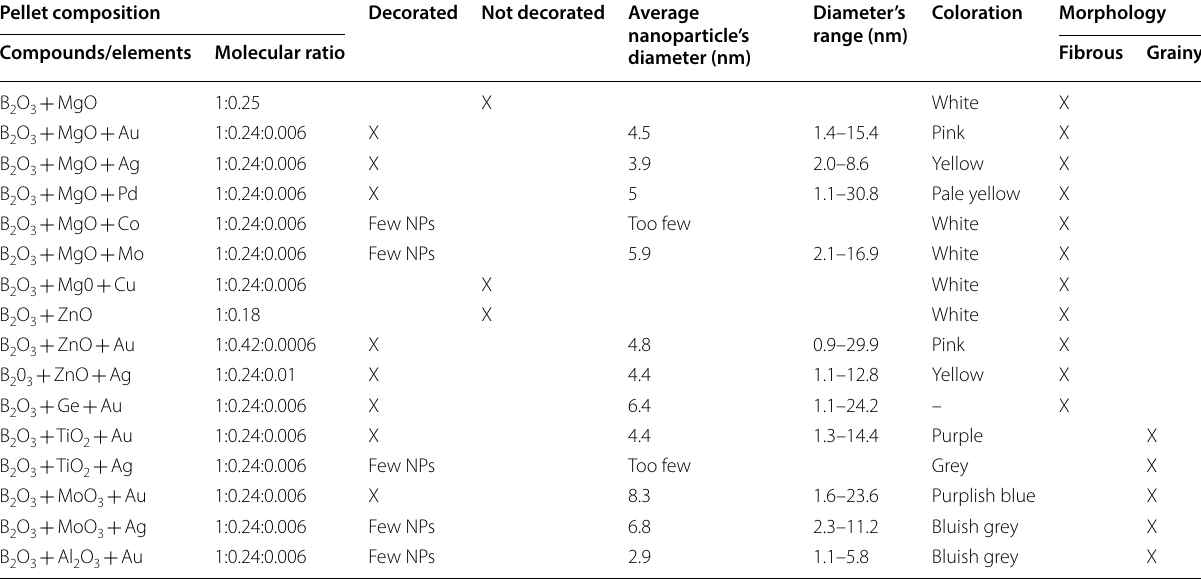
Table 1 Summary of the distinctive characteristics of all the as-produced NWs Pellet composition Decorated Not decorated Average Compounds/elements Molecular